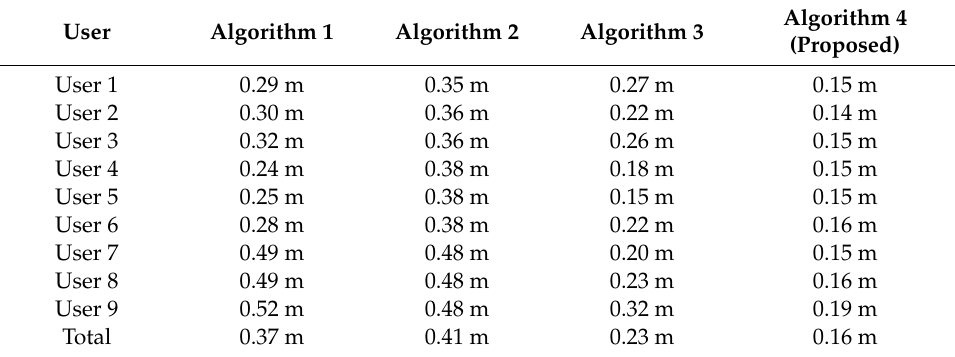
Table 1. RMS of the residual error (simulation). User 5 was located in the center and other users were located outside the network.